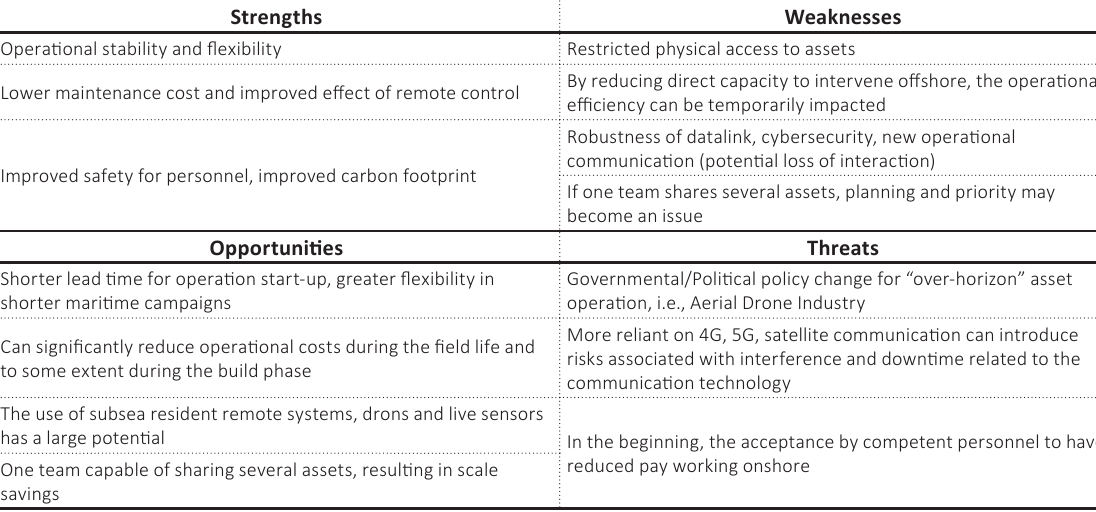
Table 3. SWOT analysis of the introduction of new ROVs systems (Suppliers’